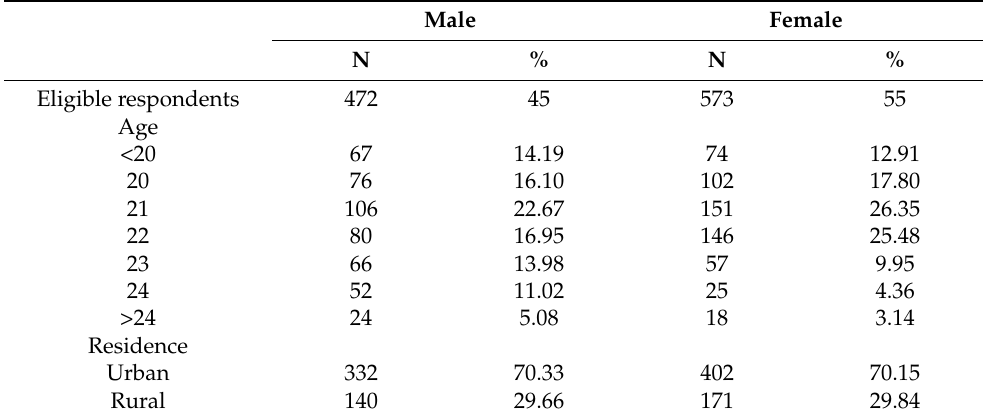
Table 2. Characteristics of the study participants.